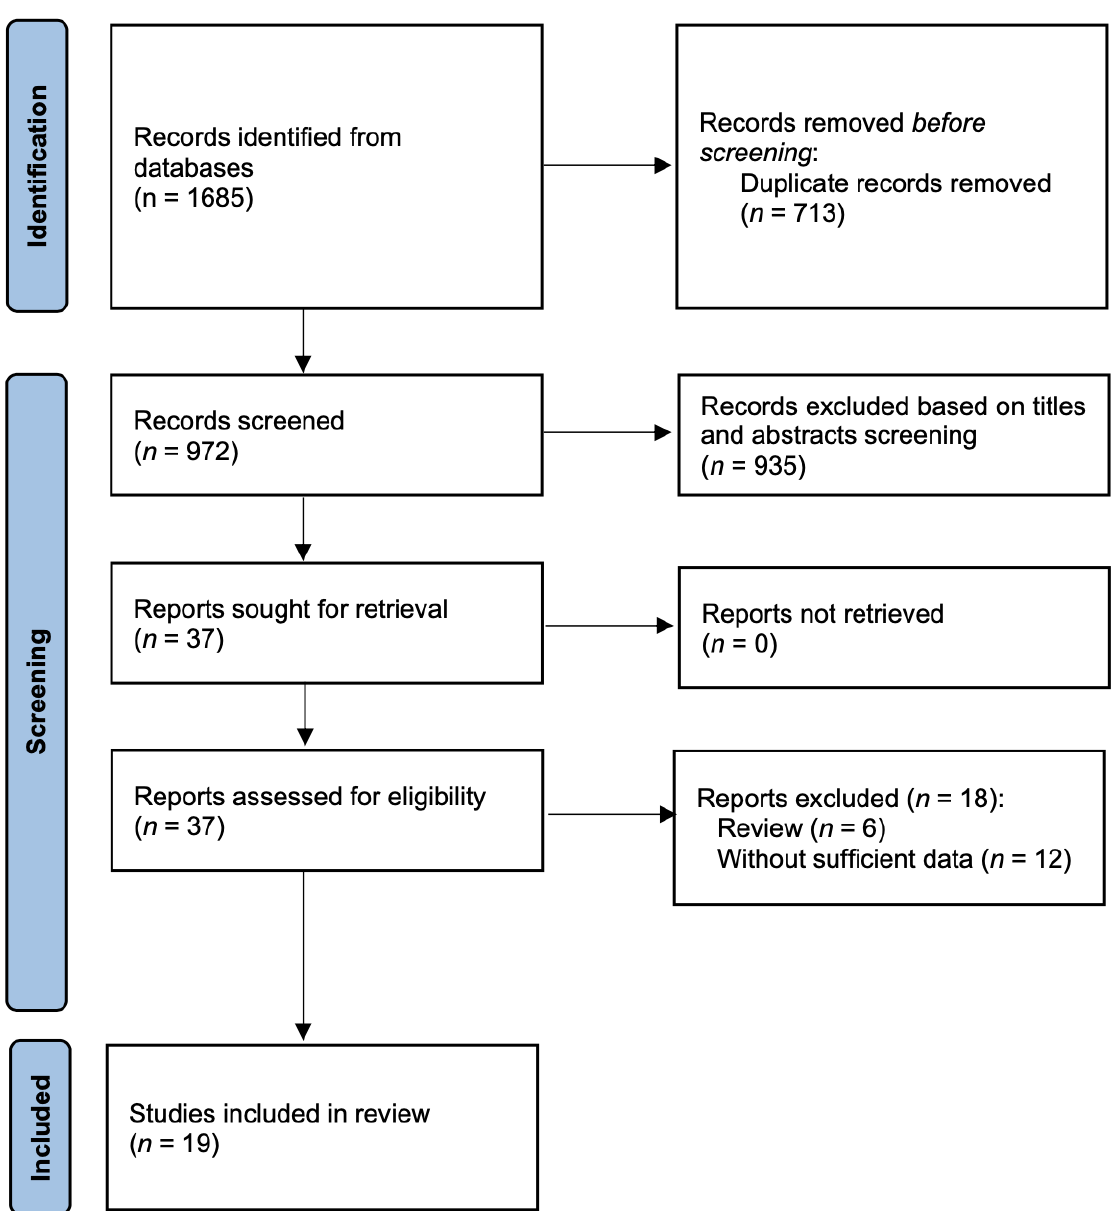
Figure 2. PRISMA flow diagram of the study selection process.